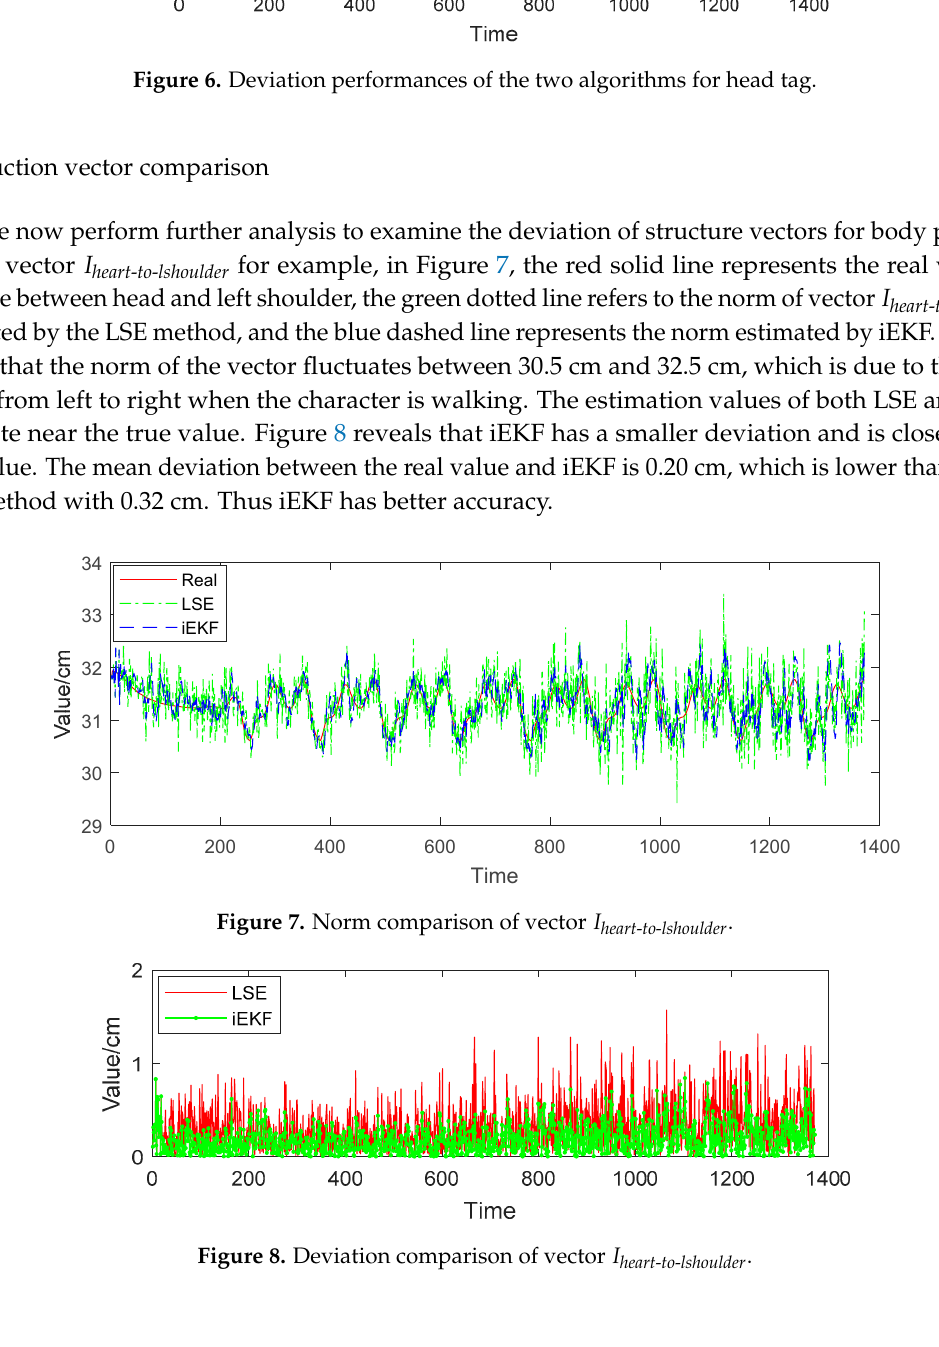
I -lshoulder-toheart